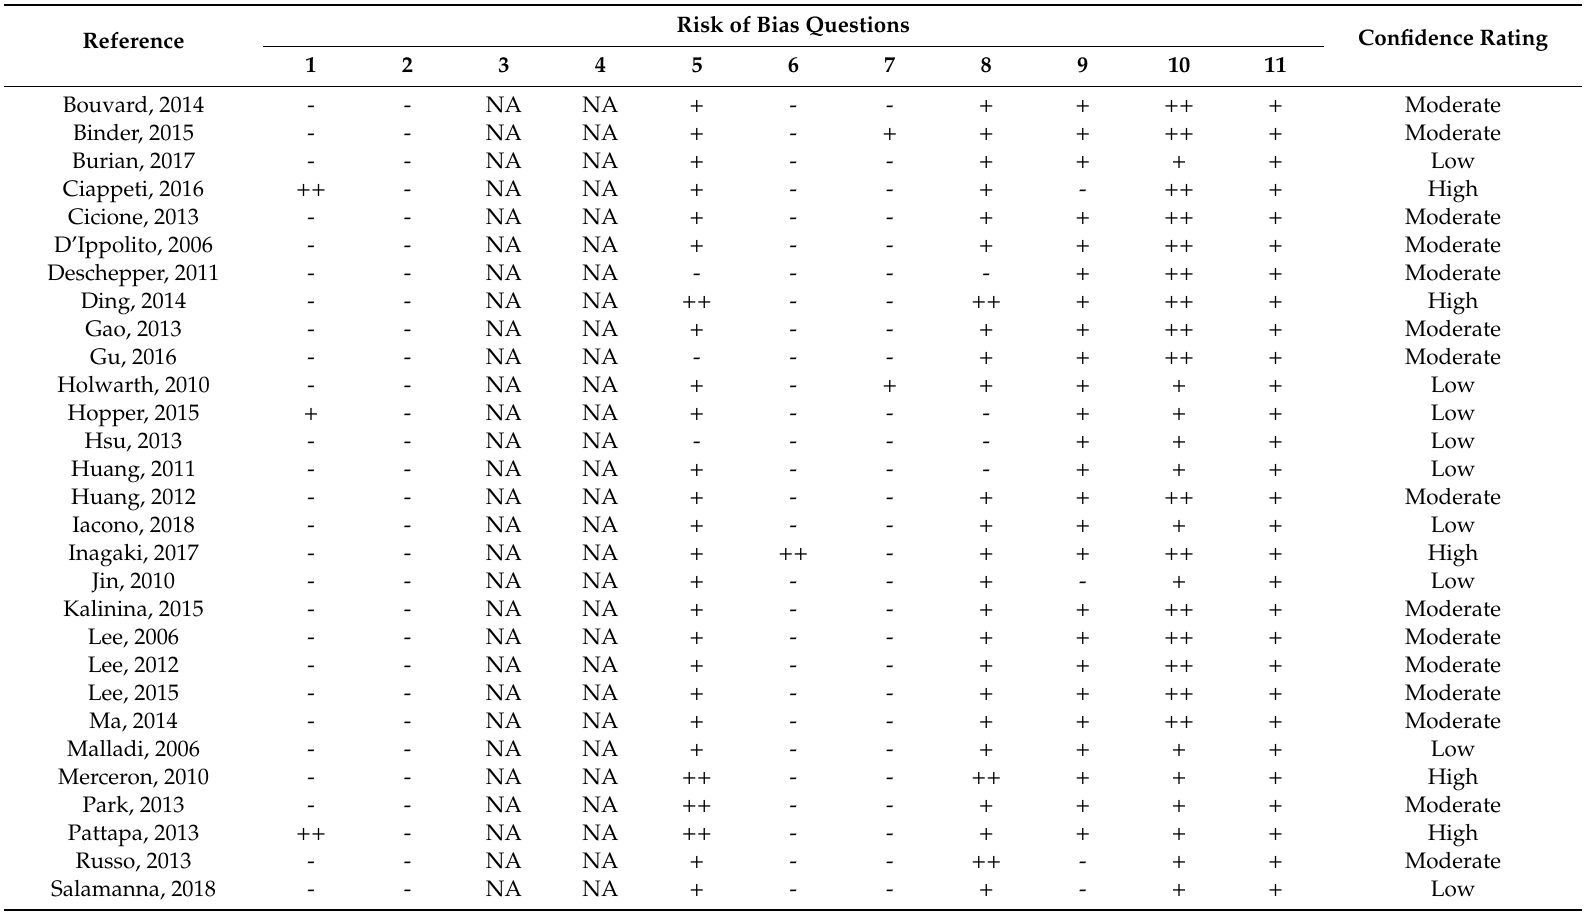
Table A1. Risk of bias and confidence rating for in vitro